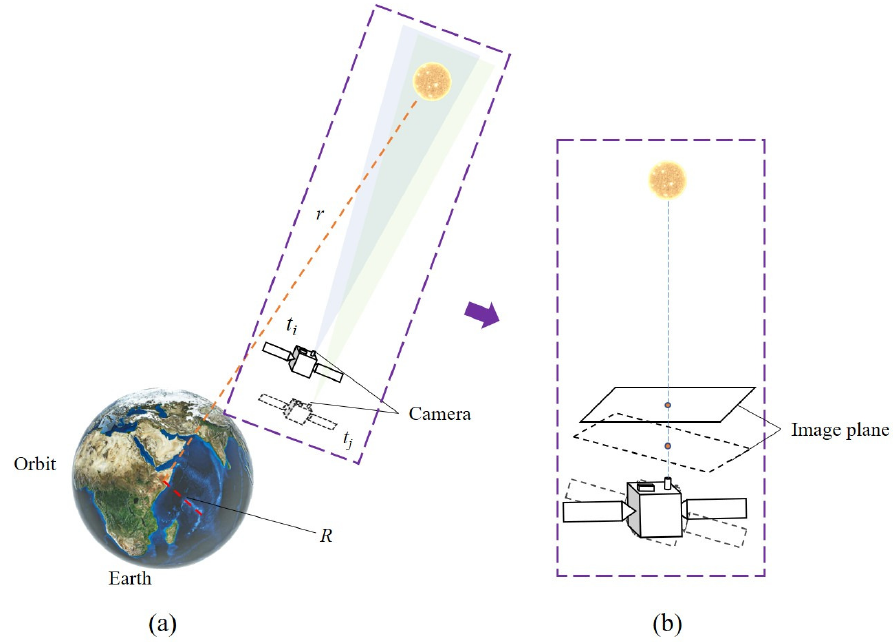
Figure 1. An in-orbit satellite under typical conditions. ( a ) Position change. ( b ) Influence of ( a ) on